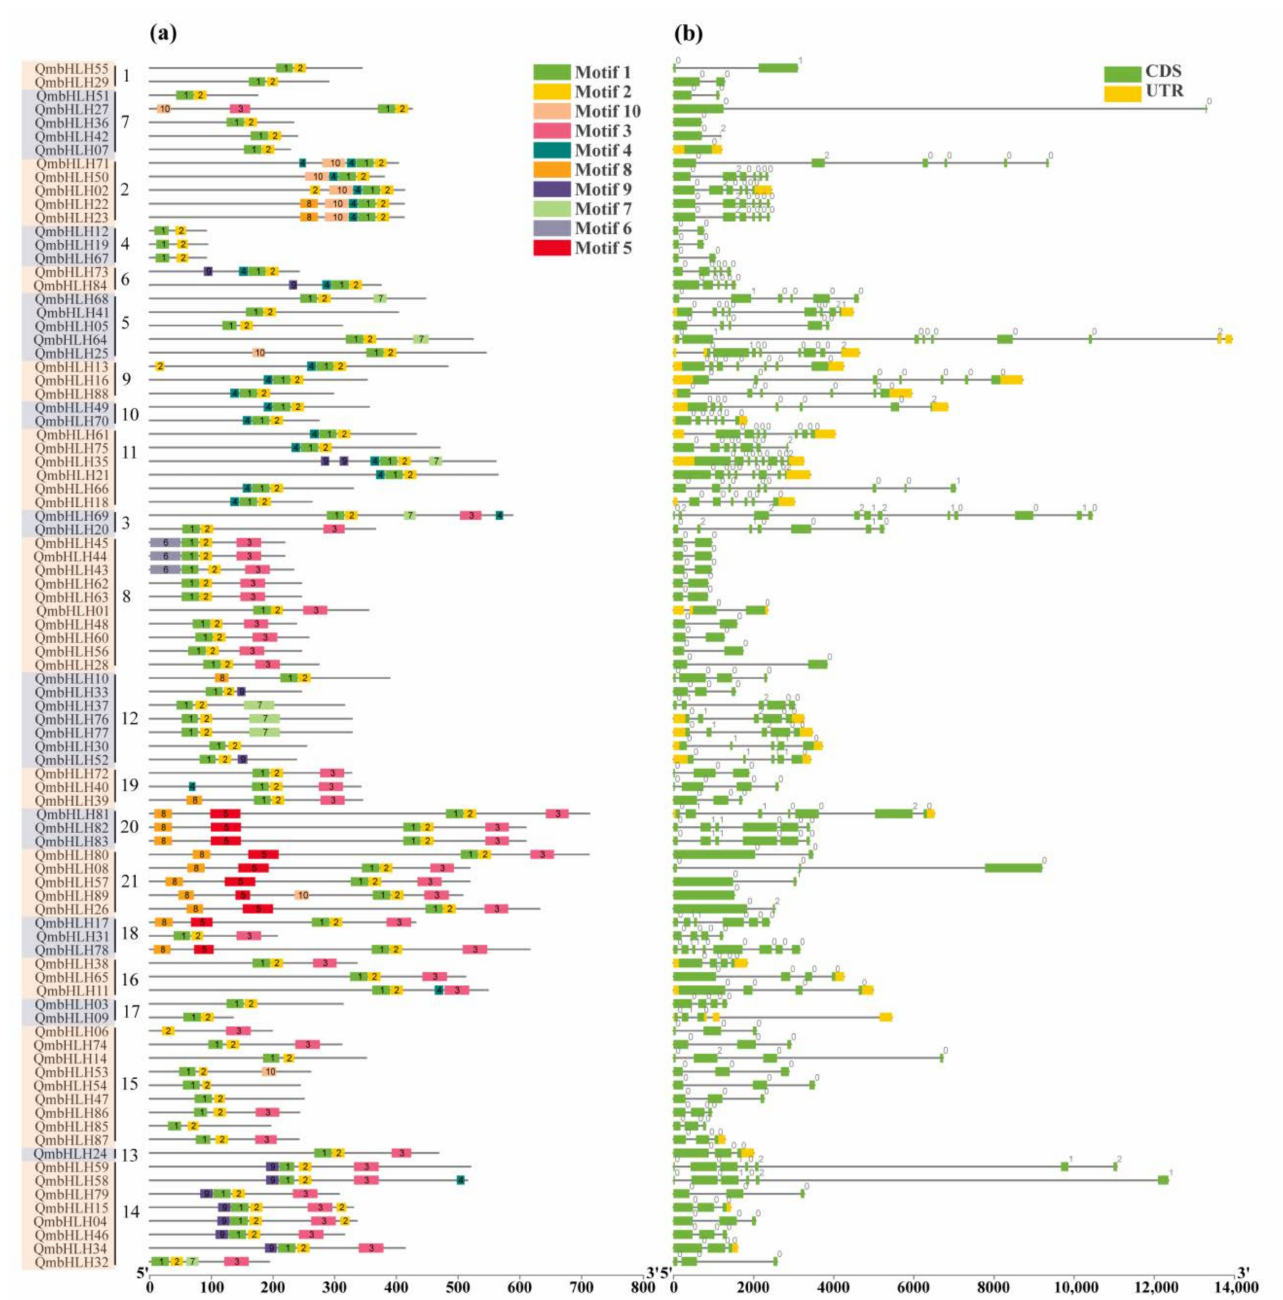
Figure 3. Conserved patterns and architectures of QmbHLH genes. ( a ) Conserved patterns in the QmbHLH proteins. The numbers 1–21 in the second column from the left in ( a ) indicates the QmbHLH genes were classified into 21 groups based on the clustering results of Figure 1. These motifs, numbered 1–10, are indicated with various colored boxes. The sequence identity of each pattern is exhibited in Figure S2. ( b ) Exon–intron architecture of QmbHLH genes. UTRs, introns, and exons are indicated with yellow rectangles, lines, and green rectangles, respectively; the numbers (0–2) represent the intron